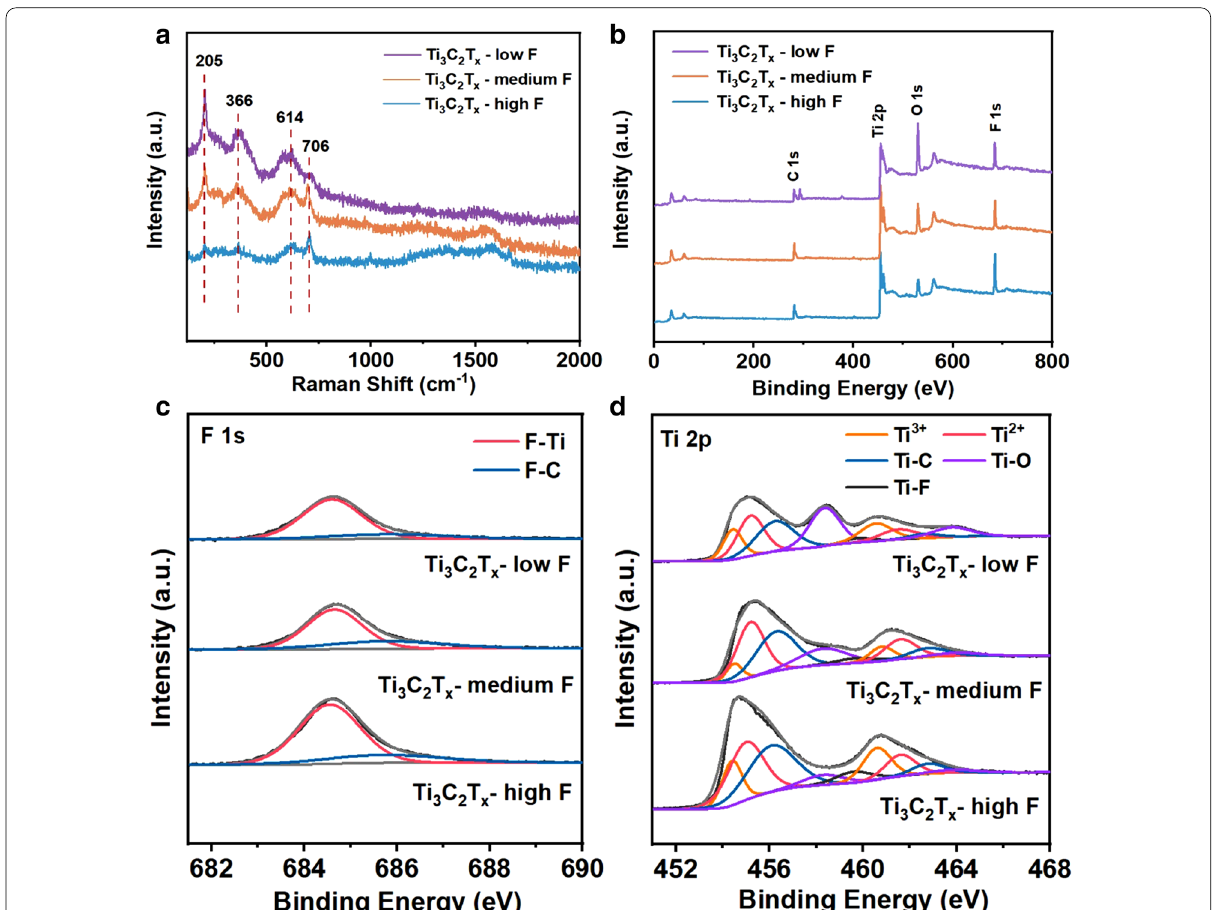
Fig. 2 a Raman spectra and b XPS spectra of Ti 3 C 2 T x ‑low F, Ti 3 C 2 T x ‑medium F and Ti 3 C 2 T x ‑high F. c F 1 s spectra, and d Ti 2p XPS spectra of